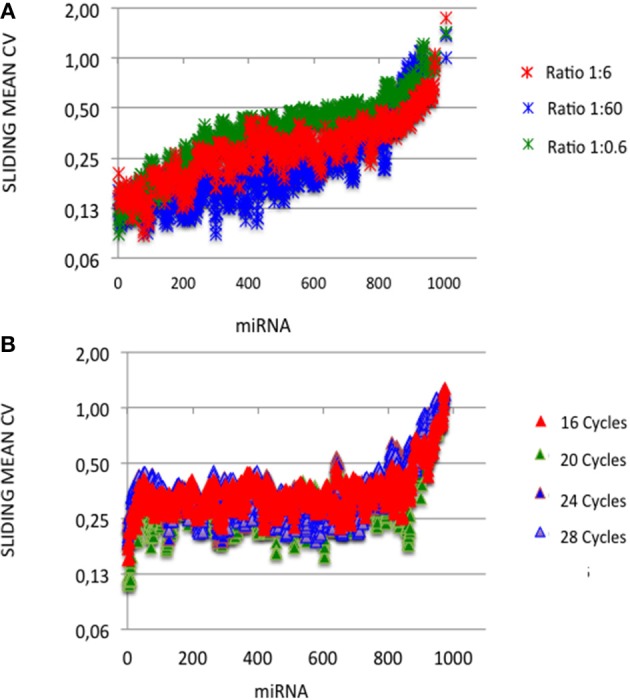
Capture efficiency robustness. We analyzed the robustness of ECs by plotting mean coefficients of variation (CVs) of ECs calculated built over sliding windows of 10 values using different miRNA:3′ adaptor ratios (A) or different amplification cycle numbers (B). miRNAs were ordered as in Figures 1, 2. Y-axes are drawn using a log2 scale. Note that the values of ECs largely overlap in each plot.